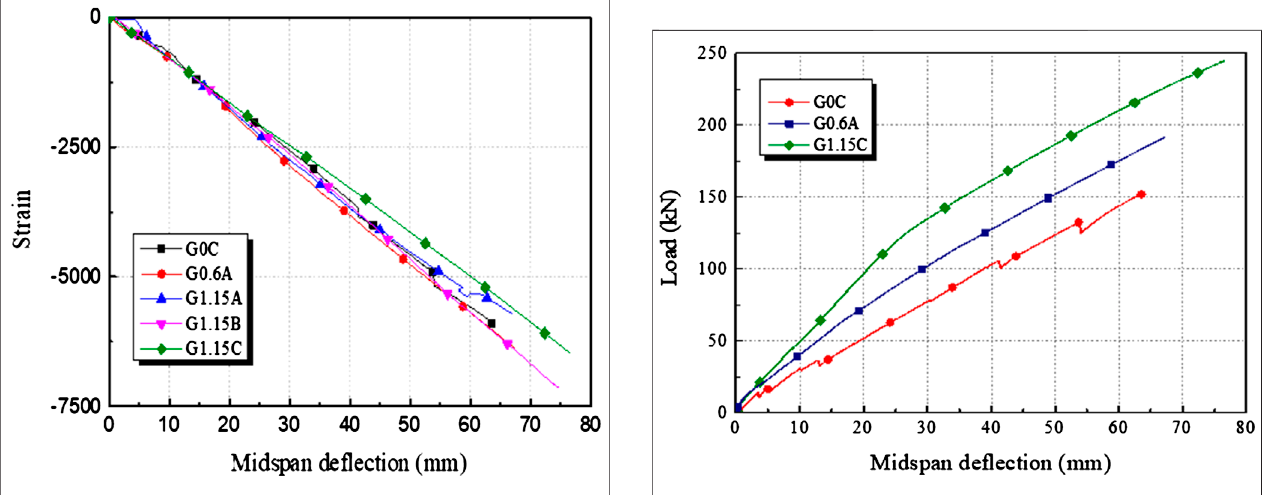
FIGURE 11 | Compressive strain-midspan de fl ection curves of all GFRP tubes.